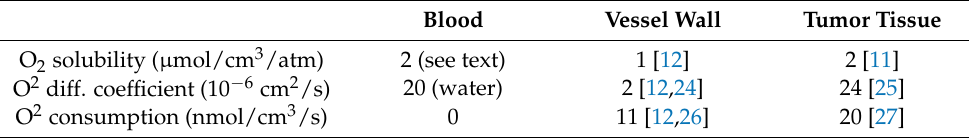
Table 1. Parameters as used for the numerical simulation of the Krogh model. Blood Vessel Wall Tumor Tissue O 2 solubility ( µ mol/cm 3 /atm) 2 (see text) 1 [12] 2 [11] O 2 diff. coefficient (10 − 6 cm 2 /s) 20 (water)